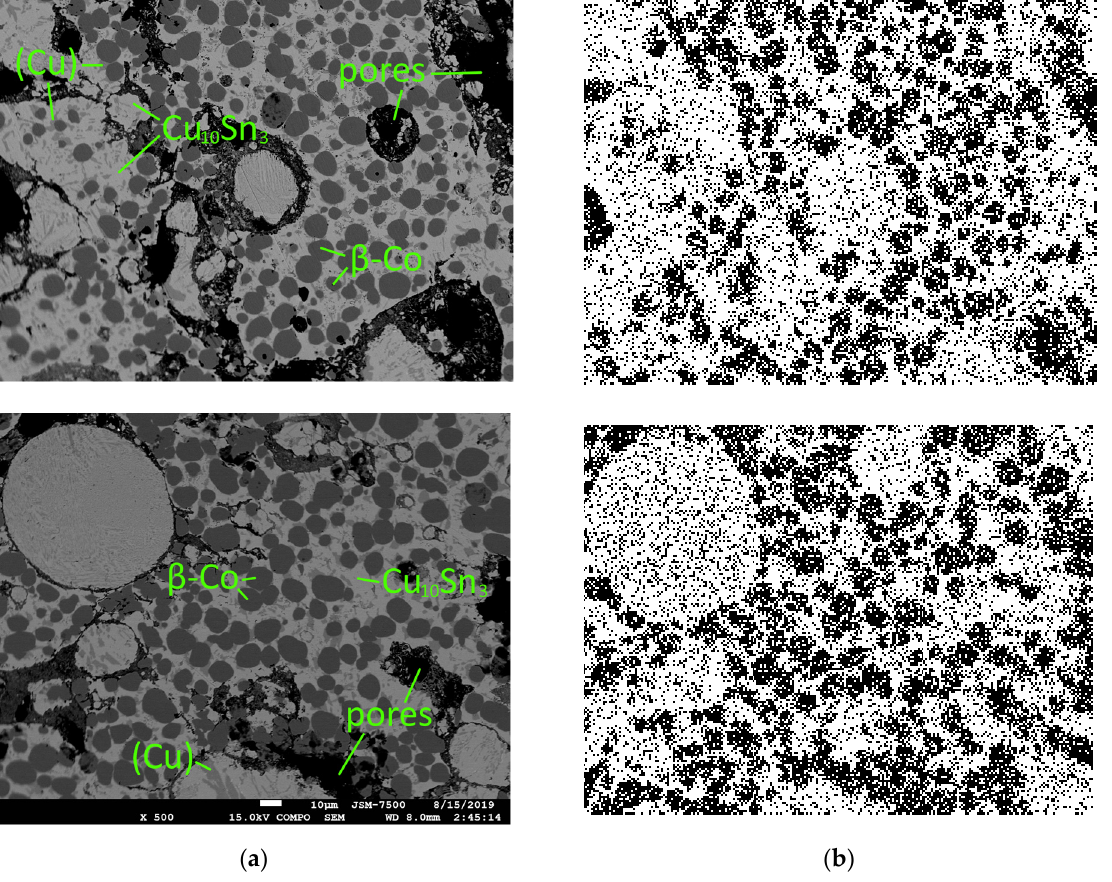
Figure 2. Structure ( a ) and tin distribution maps ( b ) for metallic binders sintered at 700–820 °C.